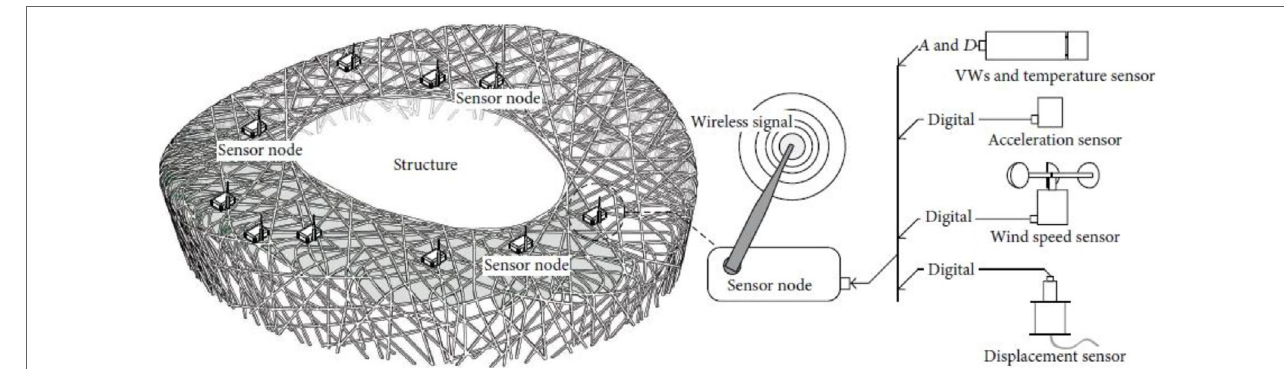
FiGURe 15 | Wireless sensor network and multiple sensors for different measurements. Reprinted from (Shen et al.,